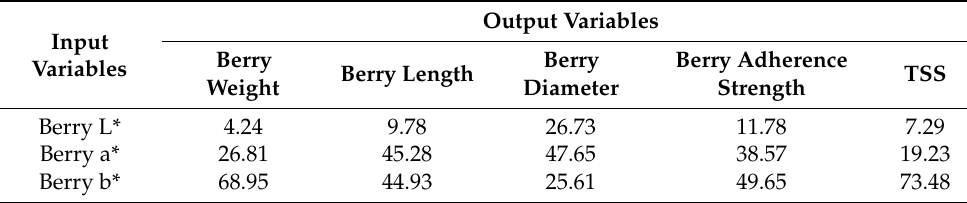
Table 6. Relative importance (%) of the input variables for ANN model predictions of berry weight, berry length, berry diameter, berry adherence strength, and